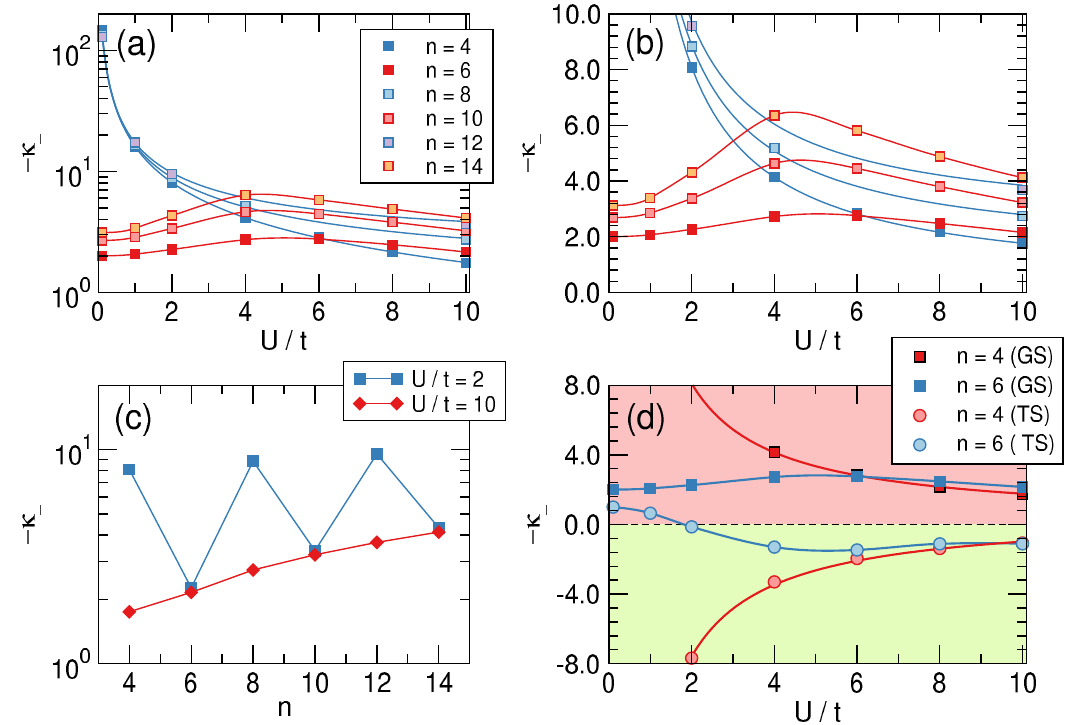
Figure 9. Upper panels: Intrinsic distortivities— κ − in a log-linear ( a ) and linear–linear ( b ) scale as functions of U / t for different values of n . ( c ) panel: Size-dependence of the distortivity in the weakly ( U / t = 2) and strongly ( U / t = 10) interacting limits. ( d ): Distortivity for the ground (GS) and the twin (TS) states for n = 4,6. Notice that κ − > 0 (green colored area) means that the structure is stable against the bond alternation